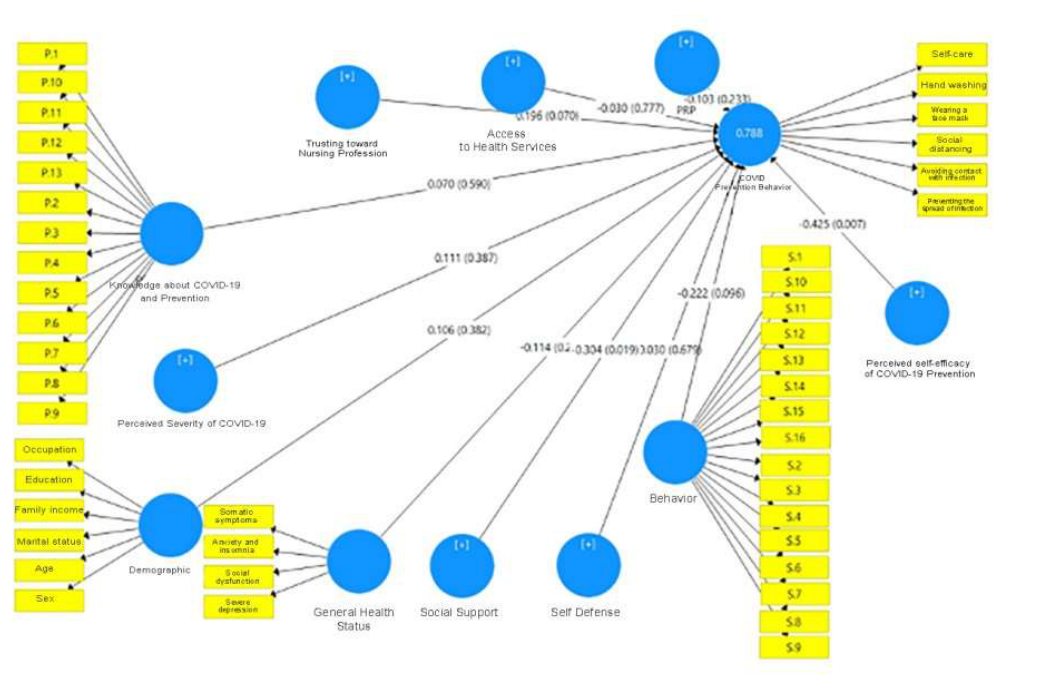
Fig. 2. Path analysis for PLS : Output Results Chronic Disease